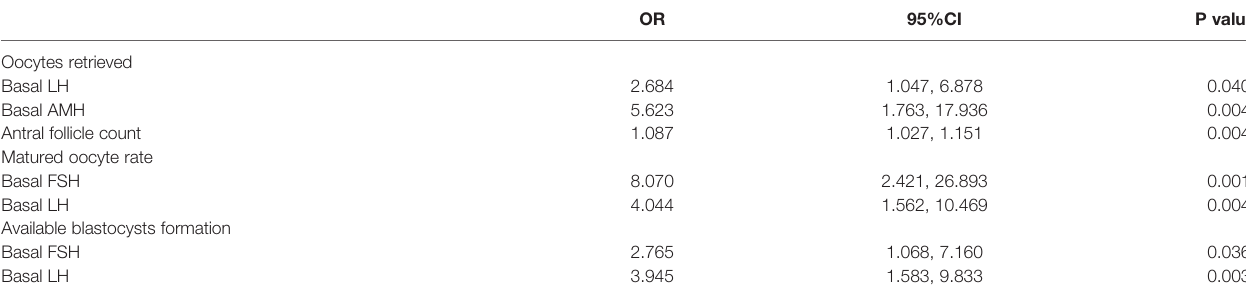
TABLE 3 | Multivariate analysis of factors in fl uencing oocytes and embryological outcomes.